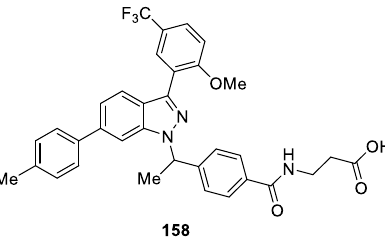
Figure 44. Chemical structure of 1 H -indazole derivative 158 .